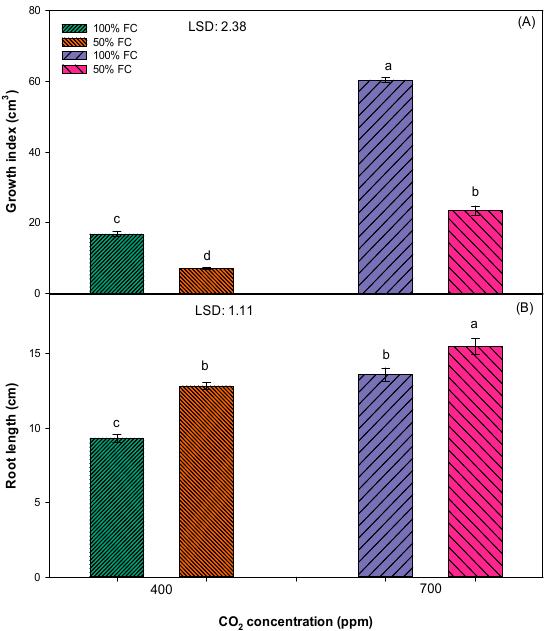
Figure 2. Effect of different [CO 2 ] and soil moisture levels on ( A ) growth index and ( B ) root length of S. cannabina . The experiment was repeated, and the pooled data from the two studies are presented here. The vertical bars represent error bars ( n = 12). LSD represents the least significance difference ( p ≤ 0.05; n = 12). Different letters (a, b, c, d) on the error bars indicate significant differences, as determined by Fisher’s protected LSD test at p < 0.05. The abbreviation FC in the figure represents the field capacity.